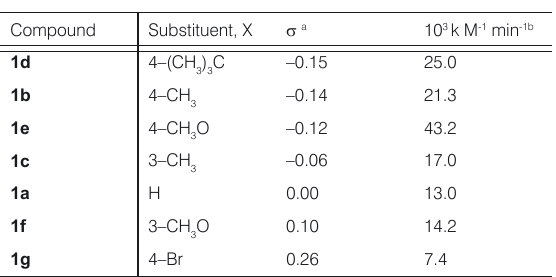
Table 2. Rate constants for the sulfonation of substituted phenyl- magnesium bromides ( 1a–g ) with phenyl tosylate ( 2 ) in THF:toluene (7:10) at 90ºC.